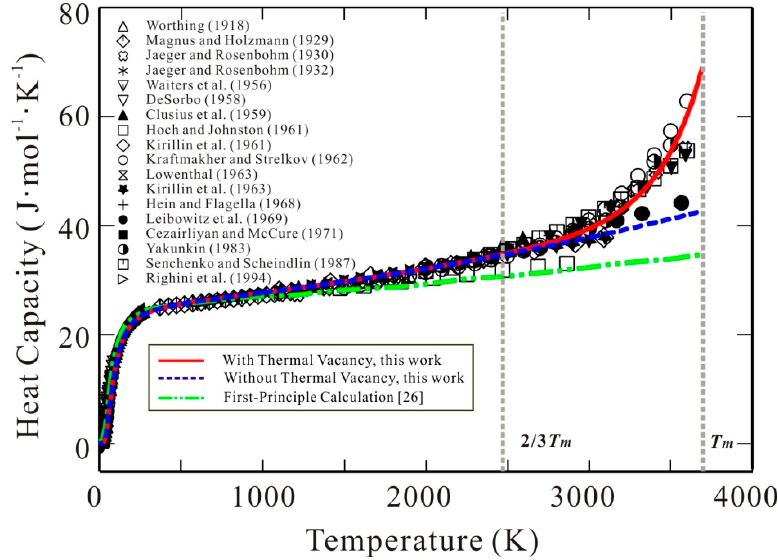
Figure 1. Heat capacity of body-centered cubic (bcc) W as a function of temperature. Symbols: Experimental data [7–23]. Solid line (red): Calculated results according to the presently established Gibbs energy for bcc W with thermal vacancy contribution. Dashed line (blue): Calculated results according to the presently established Gibbs energy for defect-free bcc W without thermal vacancy contribution. Dotted line (green): First-principles calculation [19], which does not include thermal vacancy contribution.